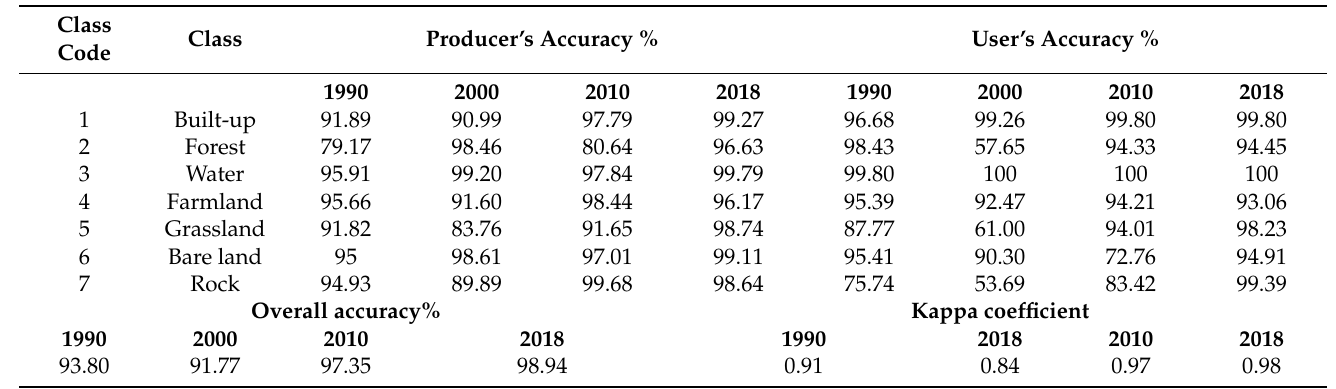
Table 8. Accuracy assessment results of classification.